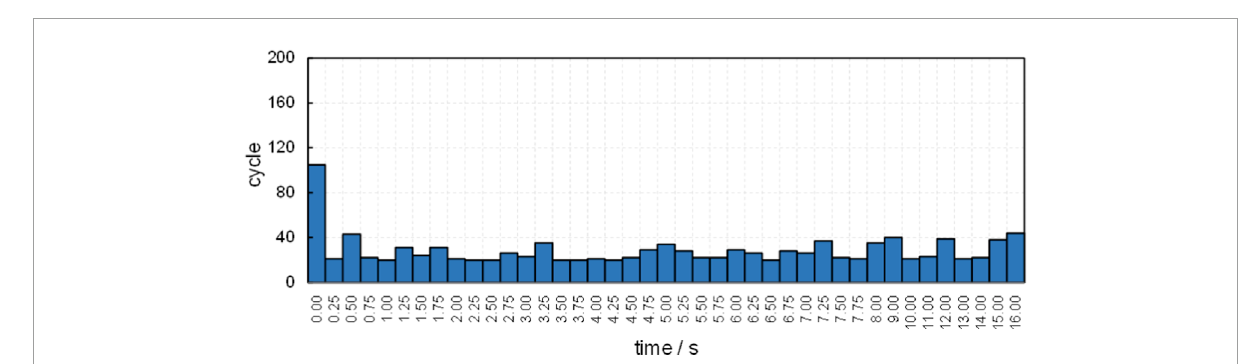
FIGURE 6 The convergence cycles given by Eq. 28 , after accelerating TD4-4’s transient calculation by